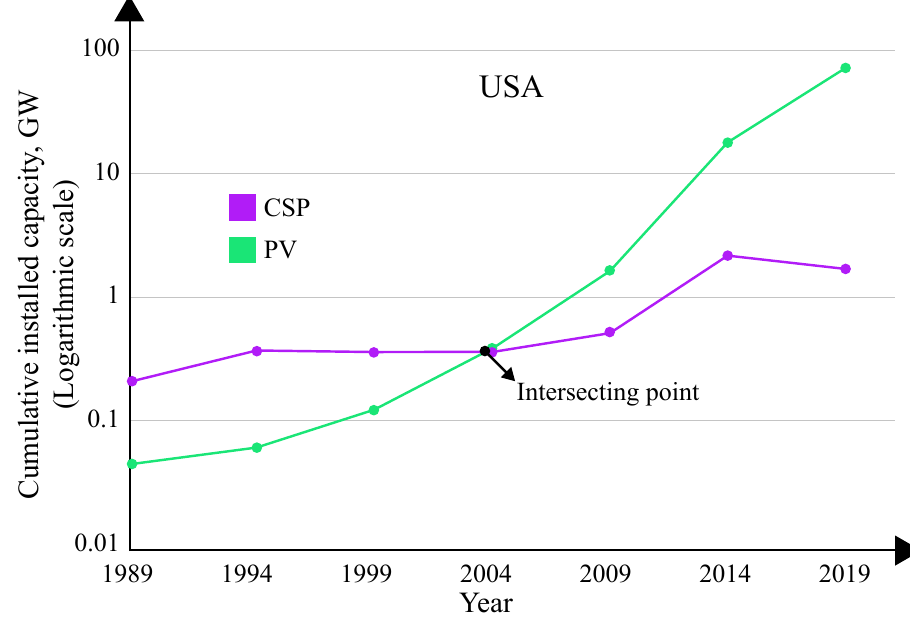
Figure 13. Timeline of CSP and PV deployment in the U.S. since solar plants were first introduced. The logarithmic scale helps to better perceive how PV caught up and surpassed CSP technology in the U.S. around the early 2000s